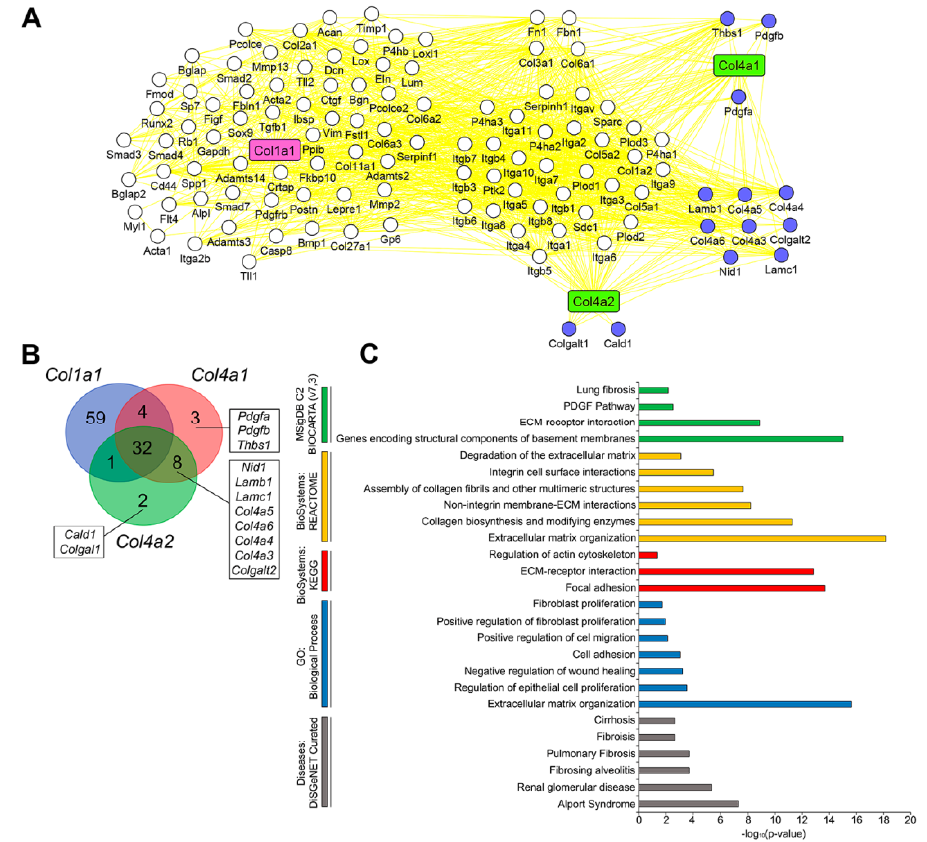
Figure 7. Functional analysis of the Col4a1 and Col4a2 and their associated genes. ( A ) PPI of Col1a1 , Col4a1 , Col4a2 , and their first neighbors. Blue nodes mark the genes, associated with either Col4a1 , Col4a2 , or both of them. ( B ) Venn diagram, demonstrating the overlap between the first neighbors of Col1a1 , Col4a1 , and Col4a2 . ( C ) Histogram, visualizing functional enrichment analysis of Col4a1 , Col4a2 , and their first neighbors. Functional enrichment analysis was performed through the ToppFun module of the ToppGene suite, using the databases MSigDB Biocarta (v7.3), BioSystems: REACTOME and KEGG, Gene Ontology: biological processes and DisGeNET curated database. For all enrichment tools, the input gene set was composed of the same 15 genes and used with default options: significance threshold of 0.05 for adjusted p − value, at least two genes from the input list in the enriched category, and the whole genome as the reference background.